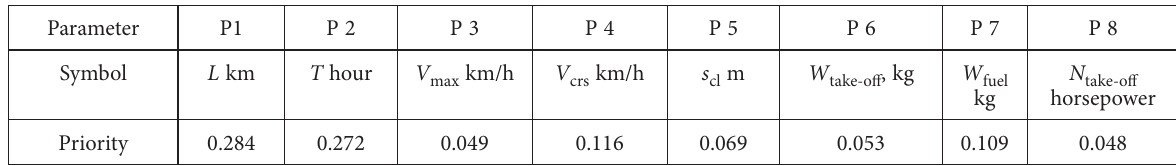
Unmanned aerial vehicle